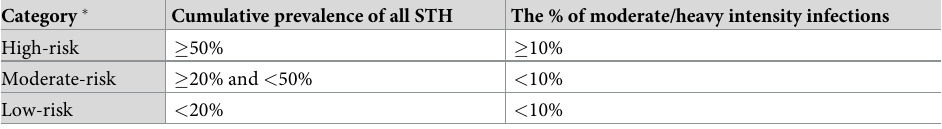
Table 1. Classification of the risk for schistosomiasis based on the WHO cut-off values of district-level prevalence. Category � Thresholds for any form of schistosomiasis High-risk � 50% Moderate-risk � 10% and < 50% Low-risk < 10% � Categories and cut-off values listed based on WHO guidelines [11].